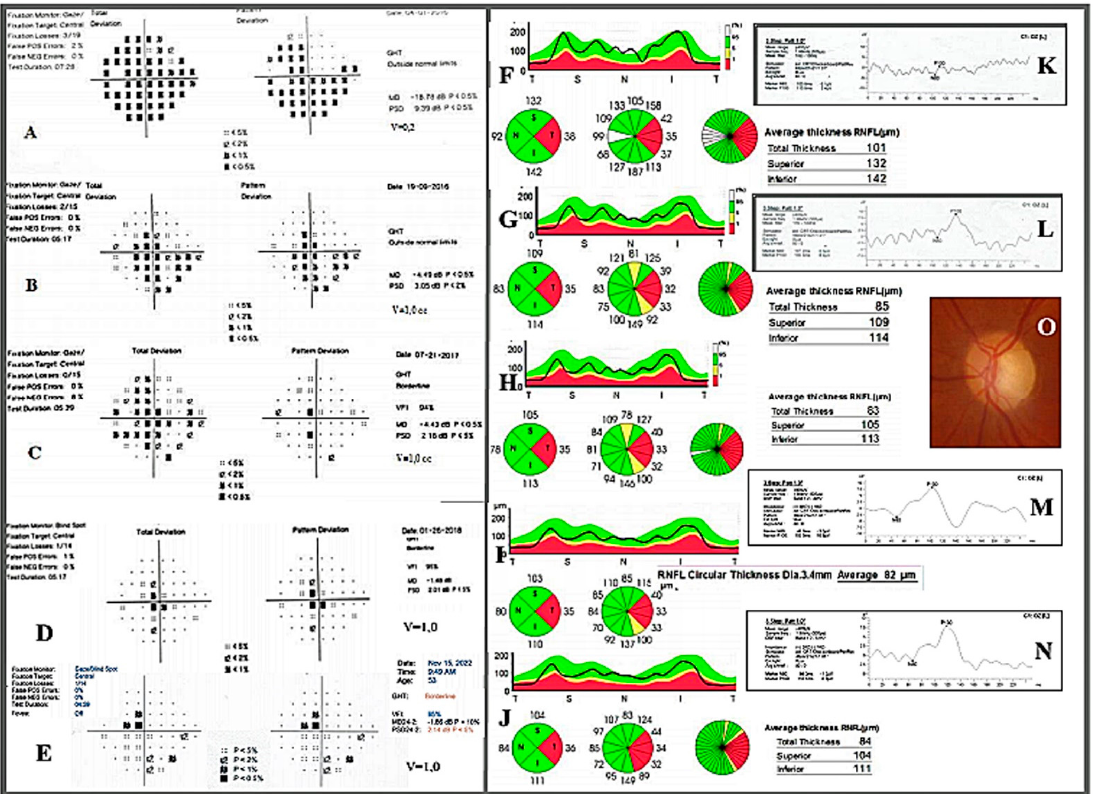
Figure 2. ( A – E ) Humphrey 24–2 standard automated perimetry of the left eye. ( F – J ) RNFL SS–OCT examination of the left eye. ( K – N ) PVEP responses obtained from the left eye, a week before the surgery ( A , F , K ), 5 months after the surgery ( B , G , L ), 15 months after the surgery ( C , H ), 22 months after the surgery ( D , I , M ), and 78 months after the surgery ( E , J , N ). ( O ) Pale optic nerve disc of the left eye. Follow-up MRI (Figure 3) and CT (Figure 4) scans showed a contrast enhancement area with tumor residue but with no sign of progression. There was no tumor recurrence or CDVA and VF deterioration at the follow-up of 78 months.